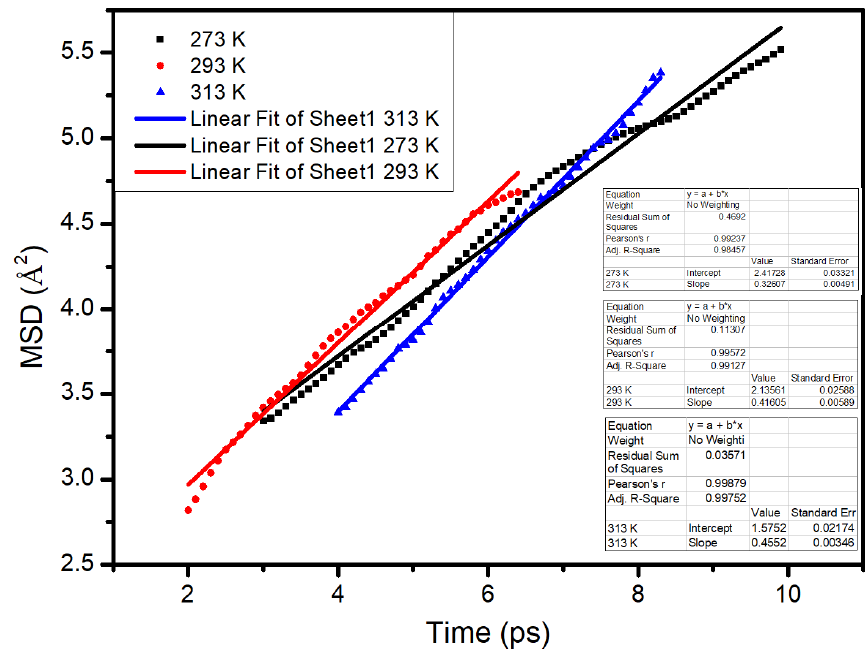
Figure 19. Fitting results of the second stage over time.